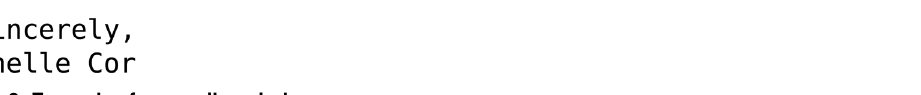
Fig 2. Example of an email